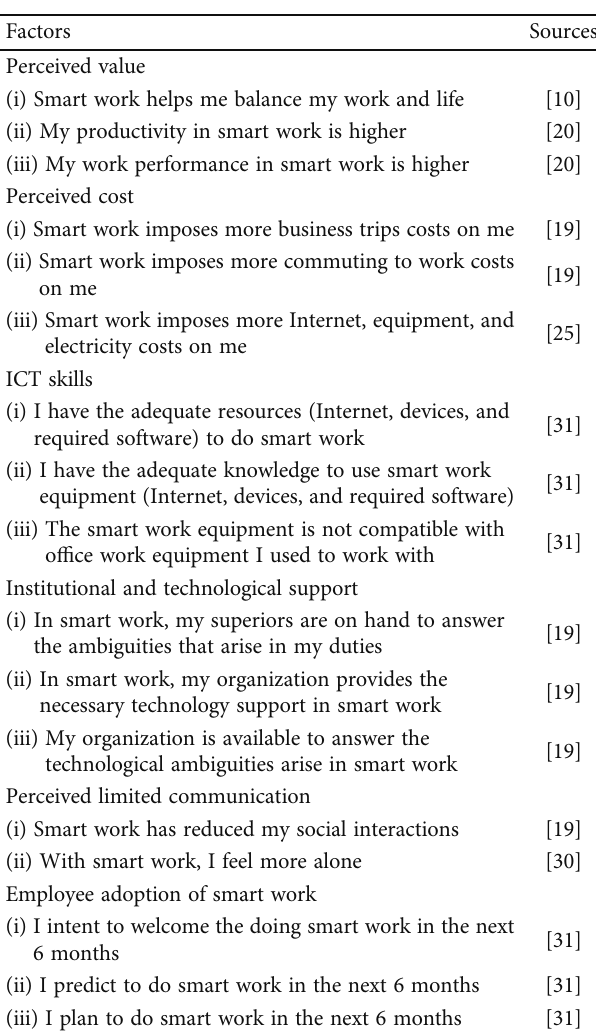
Table 1: Questionnaire